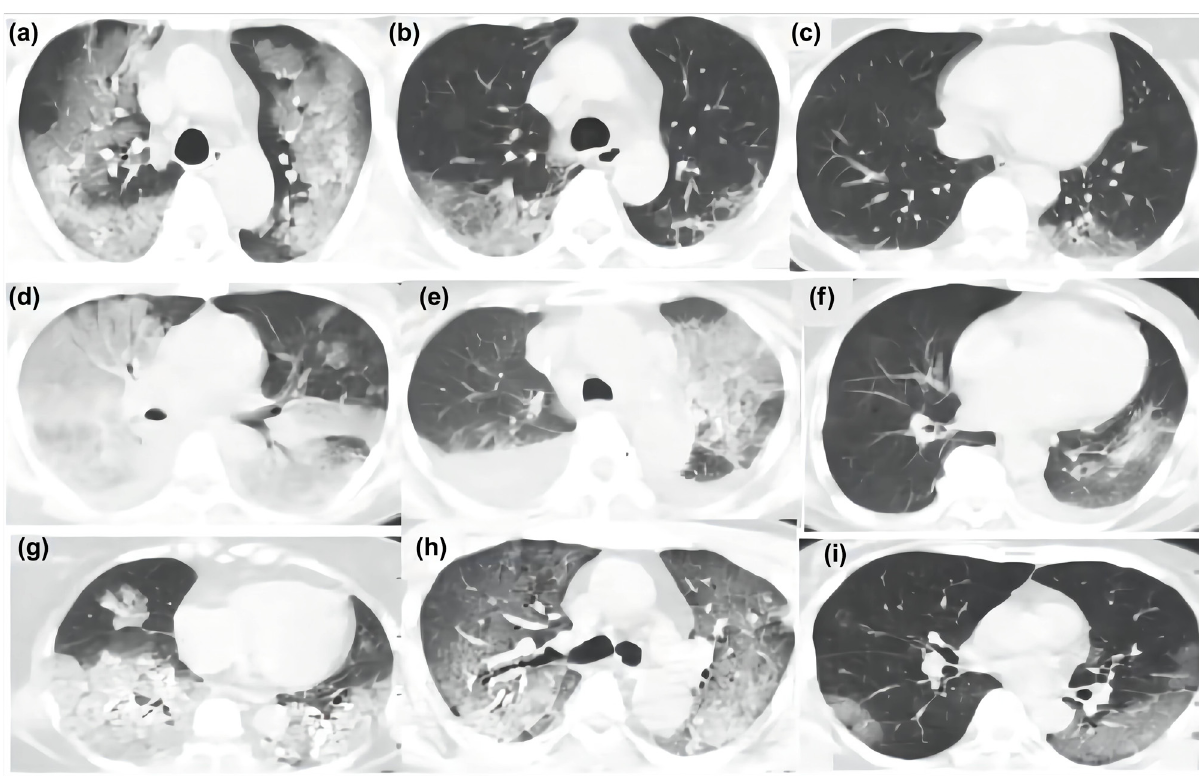
Figure 1: Chest CT images of patients with severe COVID - 19 ( a – c ) , H7N9 ( d – f ) , and H1N1 ( g – i ) . Ground - glass opacity was common in both the COVID - 19 group and the in fl uenza A group. Pleural e ff usion was more common in the in fl uenza A group, and the crazy - paving pattern was more common in the COVID - 19 group.